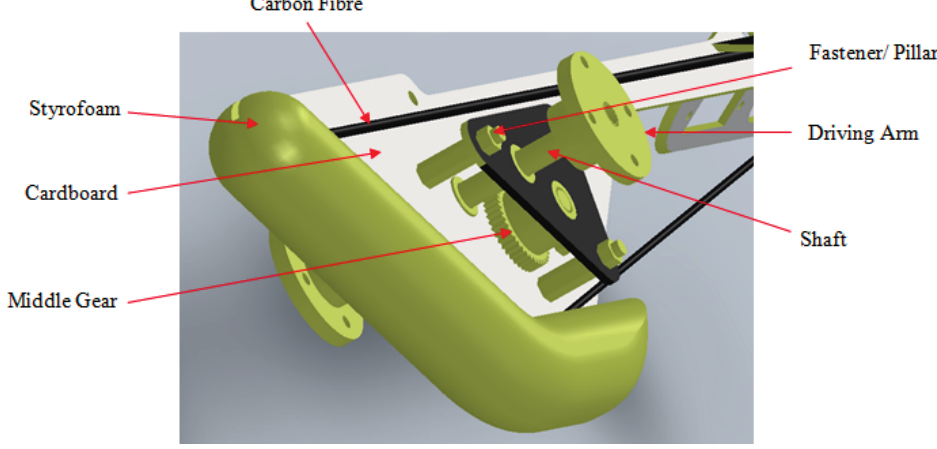
Figure 15. Left side view of flapping mechanism (computer aided design (CAD)